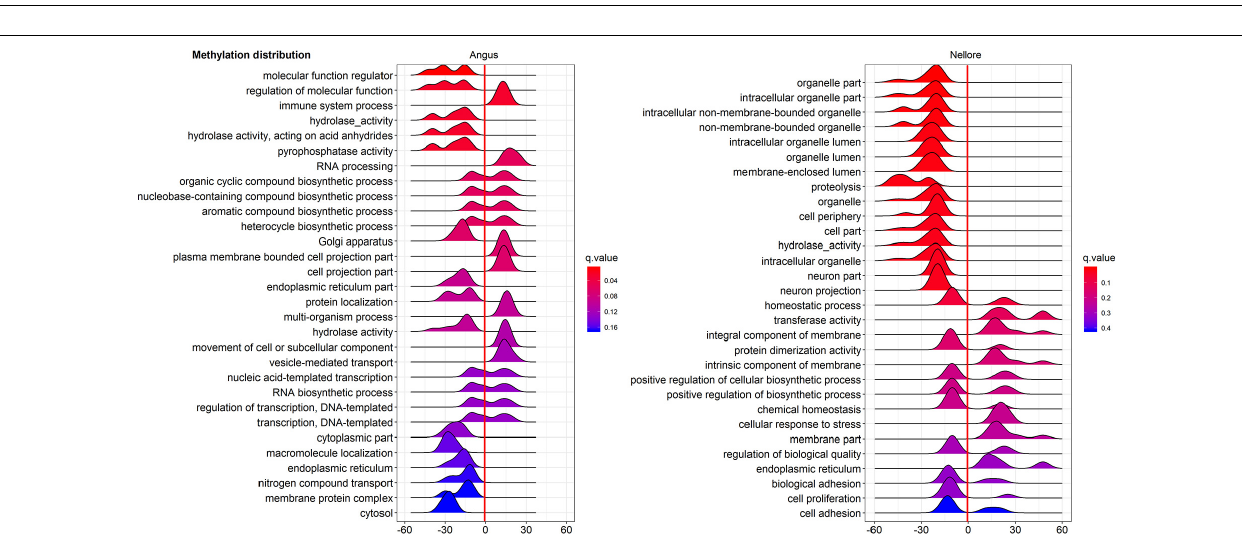
FIGURE 5 | KEGG analysis of DMGs in Angus (left side) and Nellore (right side) in challenge and recovery periods. Peak hight is proportial to the number of differentially methylated genes, color to p value. Negative values indicate hypo-methylation, positive values hyper-methylation during heat stress.